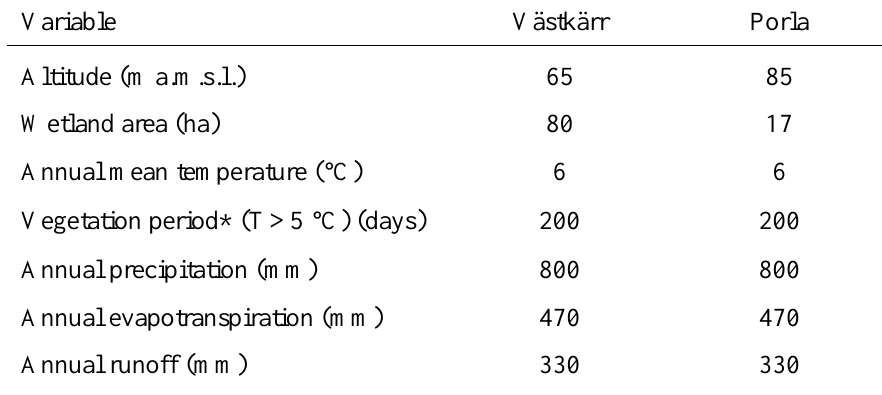
Table 1. Geographical and climate characteristics of the Västkärr and Porla wetlands (Raab & Vedin 1995). The meteorological data are mean values for the period